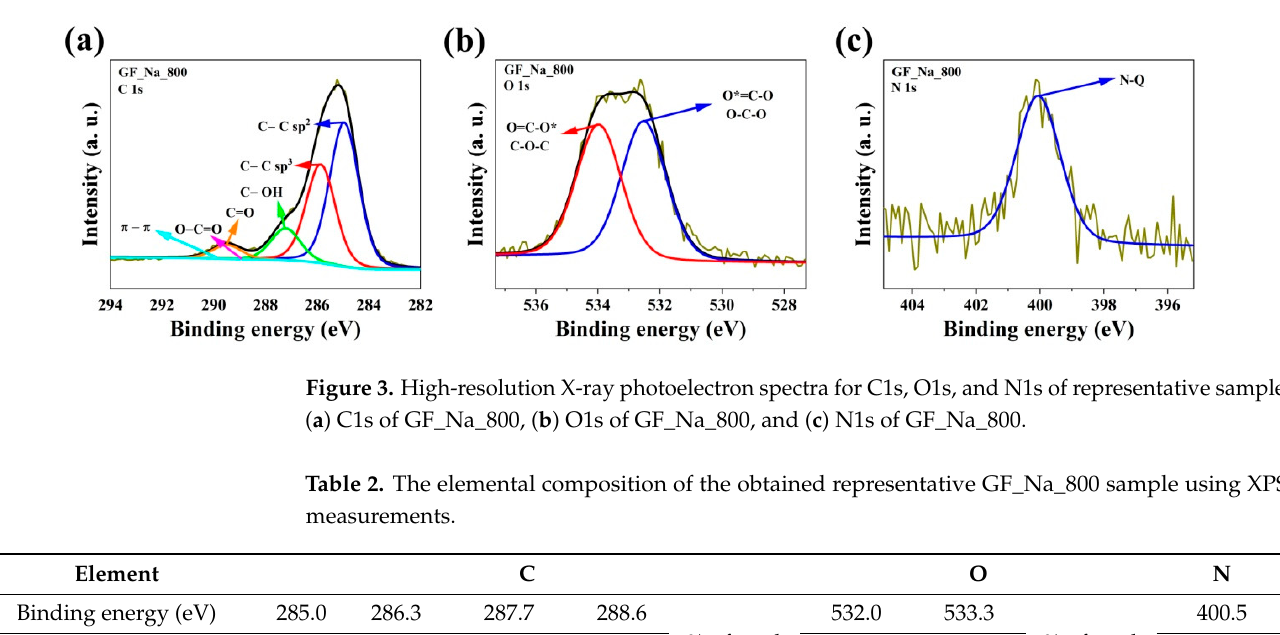
Table 3. Results of Raman spectra and D, G, and 2D band data for obtained materials.